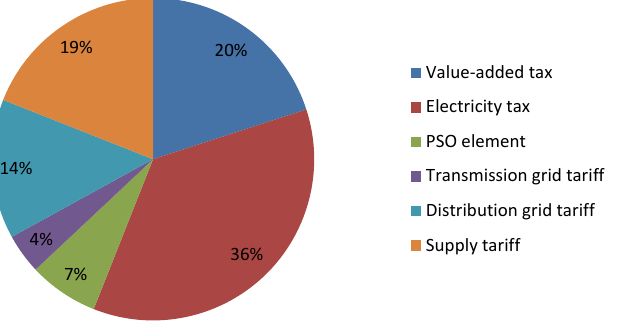
Figure 3. Composition of the residential electricity price, simplified for a consumption of a normal household with 4000 kWh/y, average for 2012 [19]. PSO: public service